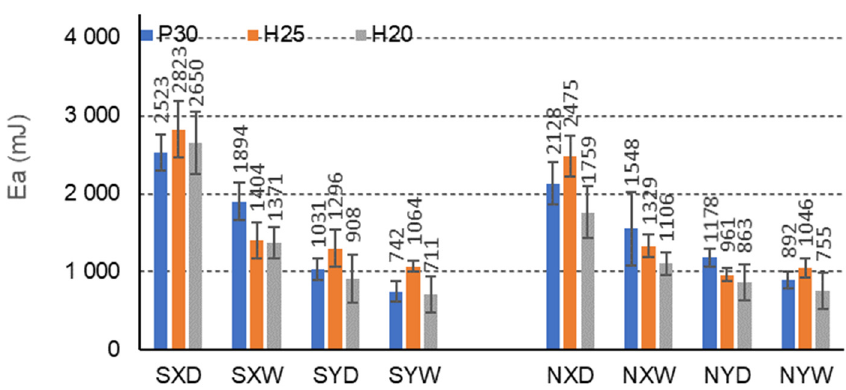
Figure 15. Illustration of the E a relationship of honeycomb panels with F-type core. Whiskers represent standard deviations.